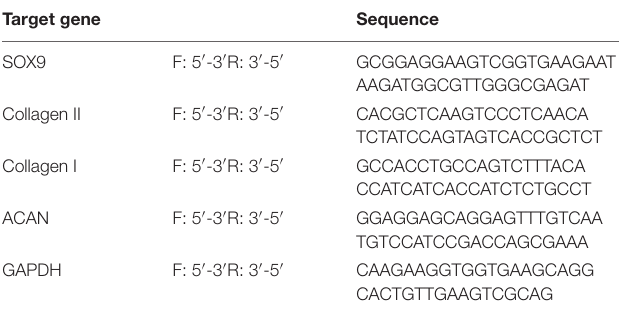
TABLE 2 | Primer sequences used for in vivo chondrogenic RT-qPCR. Target